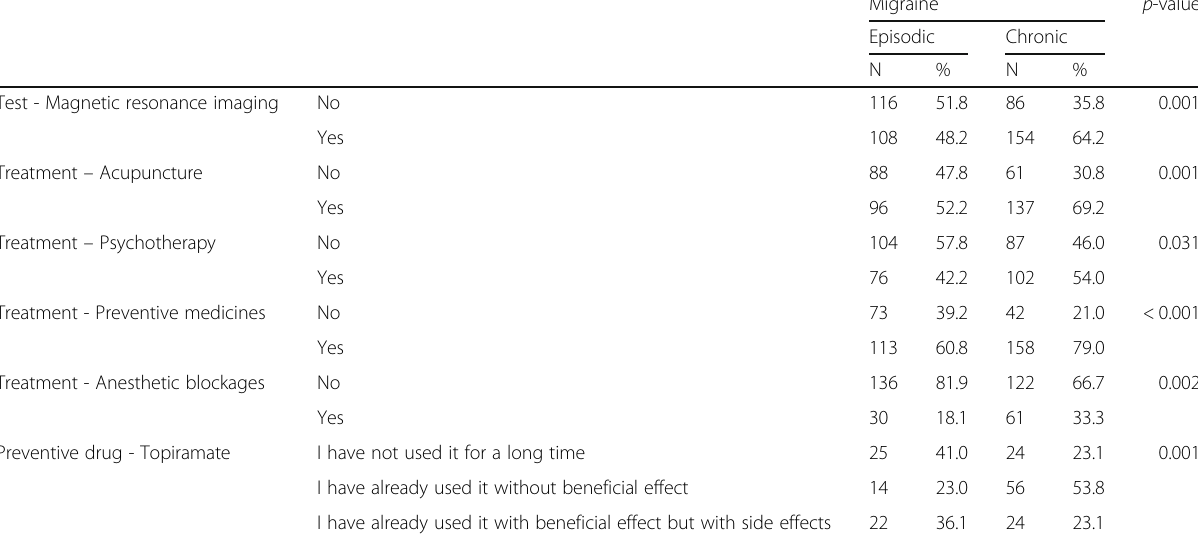
Table 7 Characteristics of patients ’ journey significantly associated with the type of migraine